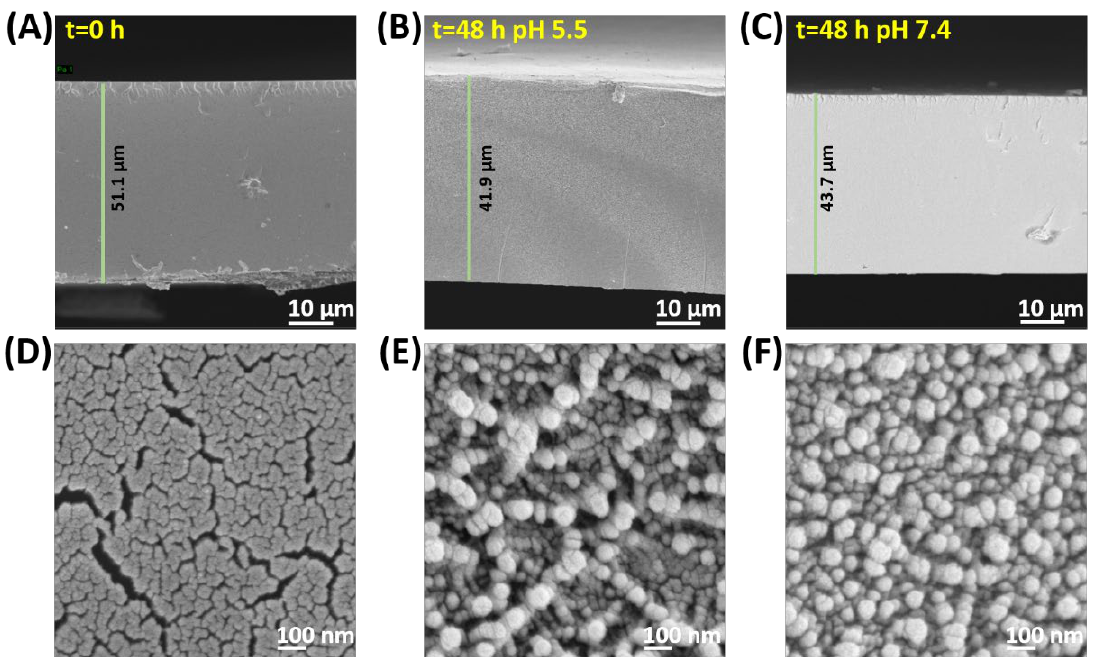
Figure 6 . SEM images of pristine SF-EPP film ( A , D) ; SF-EPP after 48 h in PBS at pH 5.5 ( B , E ) or in Figure 6. SEM images of pristine SF-EPP film ( A , D ); SF-EPP after 48 h in PBS at pH 5.5 ( B , E ) or in PBS at pH 7.4 ( C , F ). PBS at pH 7.4 ( C , F